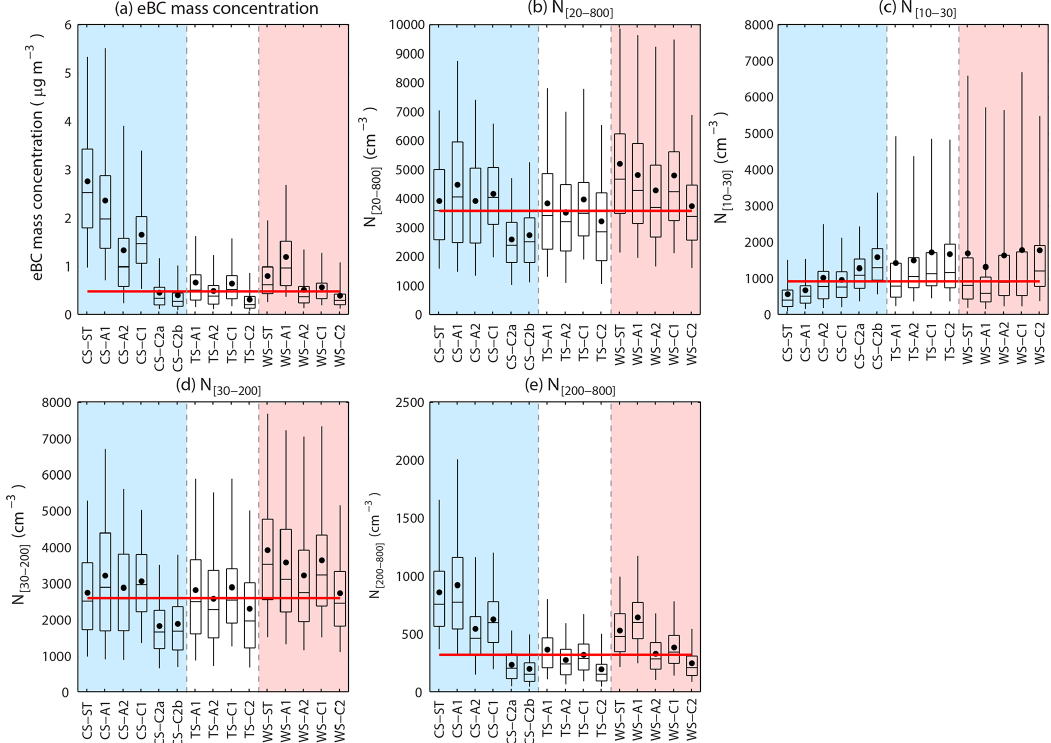
Figure 9. Average eBC mass concentration (a) and PNCs (b–e) for the 15 air mass types at the regional background sites (MEL, WAL, and NEU). In each panel, the boxes and whiskers denote the 5th, 25th, 50th, 75th, and 95th percentiles, while the dots denote the mean values. The solid red line shows the overall median